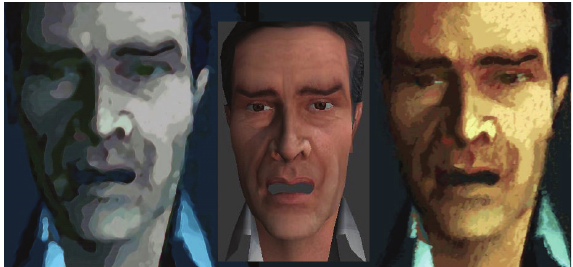
Figure 5: One image with two di ff erent painterly e ff